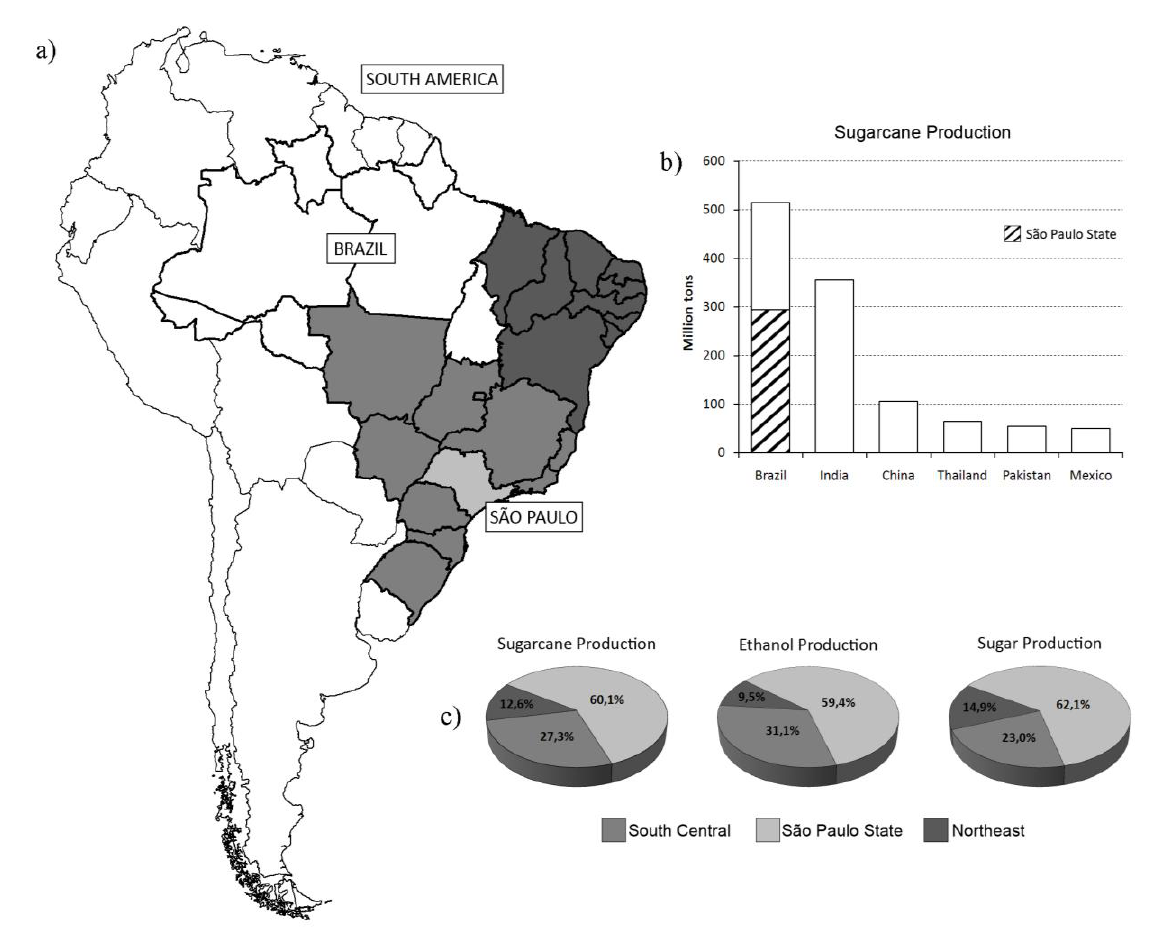
Figure 1. ( a ) Location of the South-Central region (highlighting São Paulo state) and the Northeast region of Brazil, ( b ) the six largest sugarcane producers in the world for the 2007/08 crop year, ( c ) percentage of sugarcane, ethanol and sugar production from Northeast and South-Central regions of Brazil, with São Paulo state presented